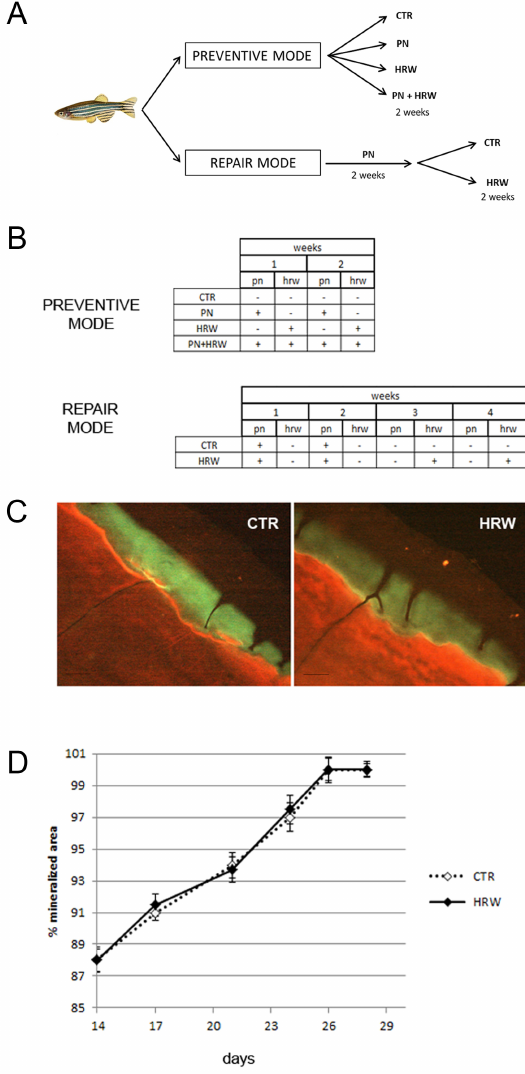
Figure 5. ( A ) Schematic representation of the experiment performed in PREVENTIVE MODE and REPAIR MODE with CTR, PN, HRW and PN + HRW samples (CTR: untreated, PN: treated with prednisolone, HRW: treated with hydrogen water, PN+HRW: treated with hydrogen water and prednisolone). ( B ) Prednisolone (pn) and hydrogen rich water (hrw) were administrated with different methods and timing in CTR, PN, HRW and PN + HRW samples in PREVENTIVE MODE or REPAIR MODE. ( C ) Exemplificative picture of the reparative process in resorption areas of HRW or untreated CTR fish after prednisolone treatment (REPAIR MODE). Green fluorescence indicates a new mineralized matrix deposed in the lacuna. Scale bar 0.02 mm. ( D ) % of scale mineralized area measured in 3rd and 4th weeks in HRW and untreated CTR fish after PN treatment (REPAIR MODE). The reparative process was not modulated by the HRW